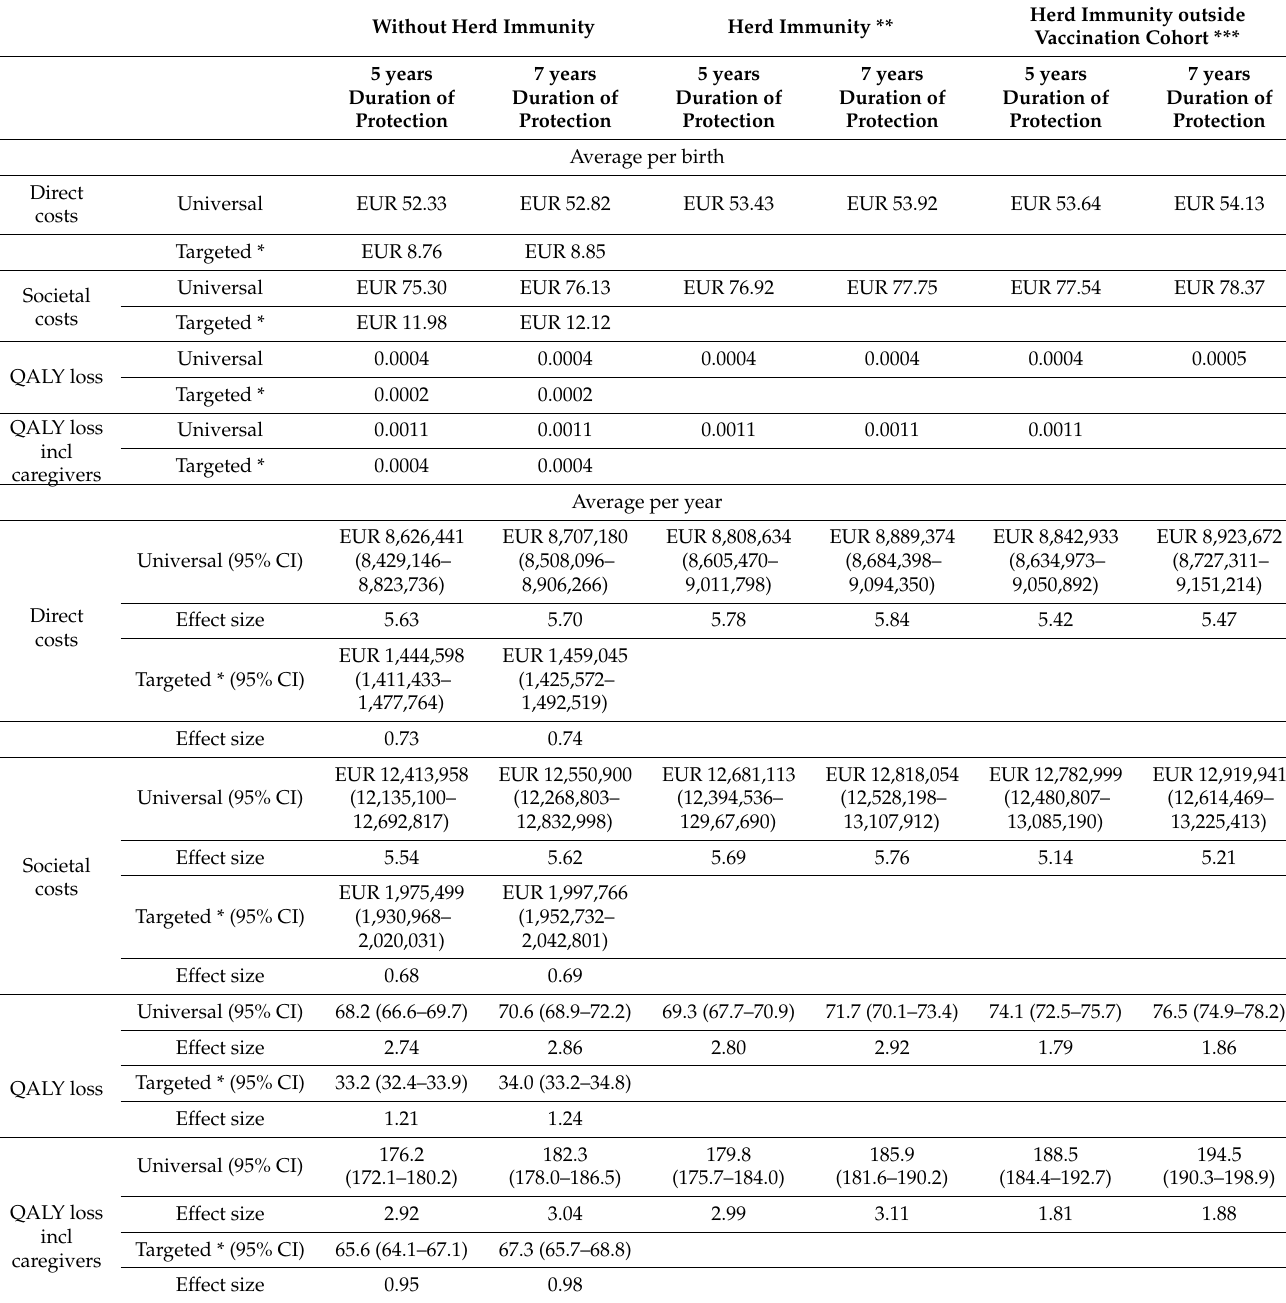
Table 8. Average avoided outcomes per year and per born child for universal and targeted vaccination. Without Herd Immunity Herd Immunity **